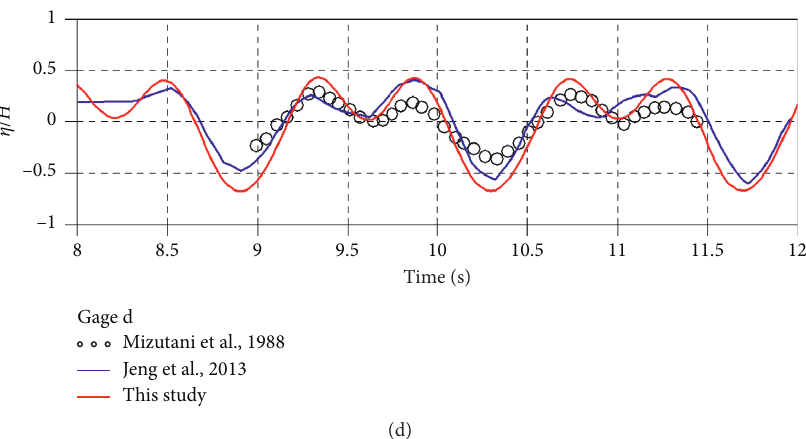
Figure 8: Comparison between measured and calculated dimensionless water surface elevations. (a) Location a; (b) location b; (c) location c; (d) location